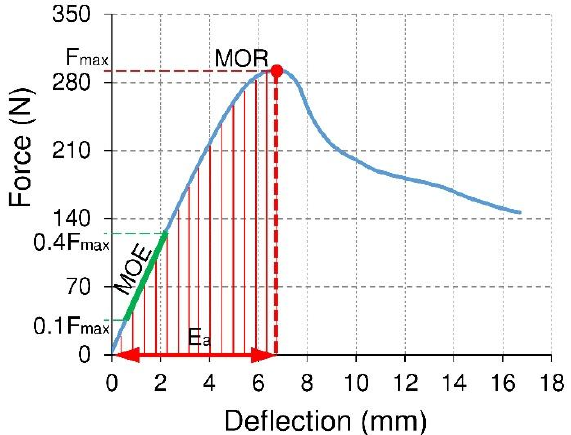
Figure 5. An example of a force-deflection relationship for examined beams made of honeycomb panels ( MOR—modulus of ruptur˛e, MOE—modulus of elasticity, F max —fracture force, E a —absorbed energy).